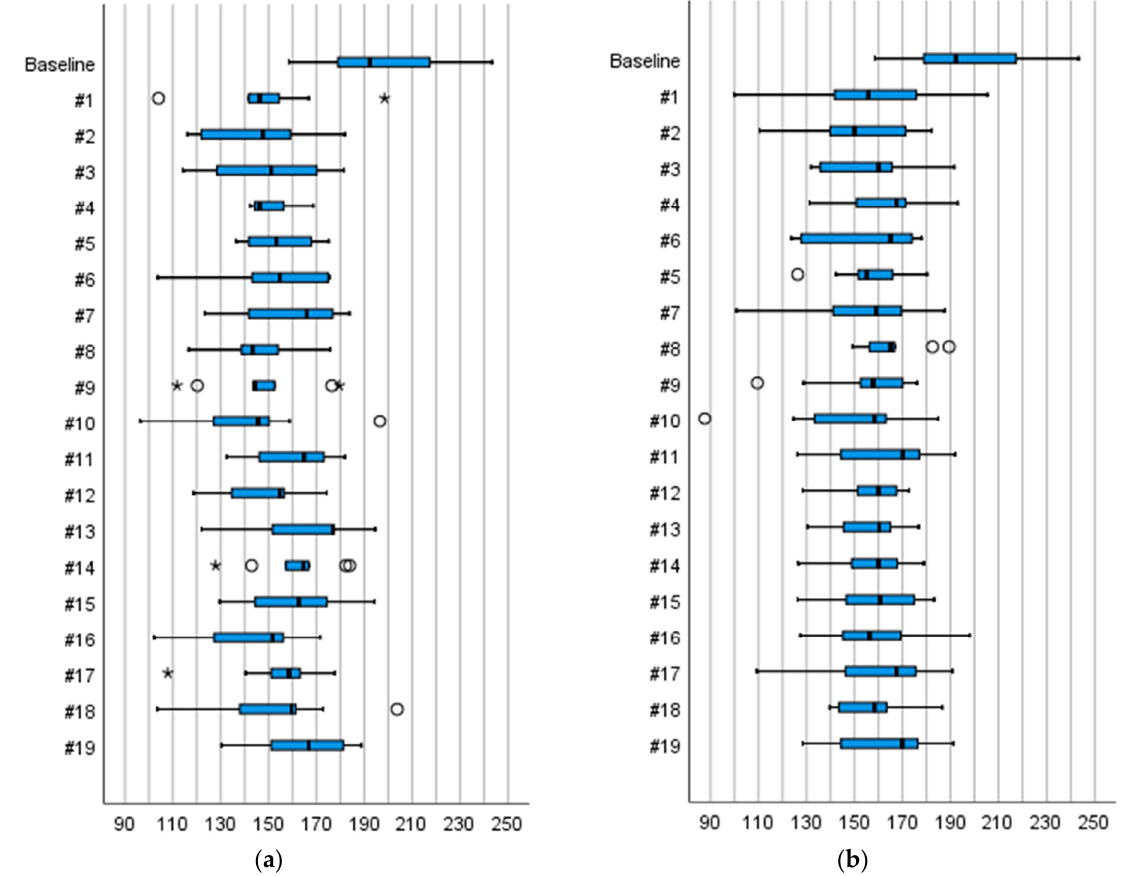
Figure 5. ( a ) Maximum gait speed (cm/sec) on uncovered ice in comparison to baseline speed (without the device), and ( b ) maximum gait speed on snow-covered ice.